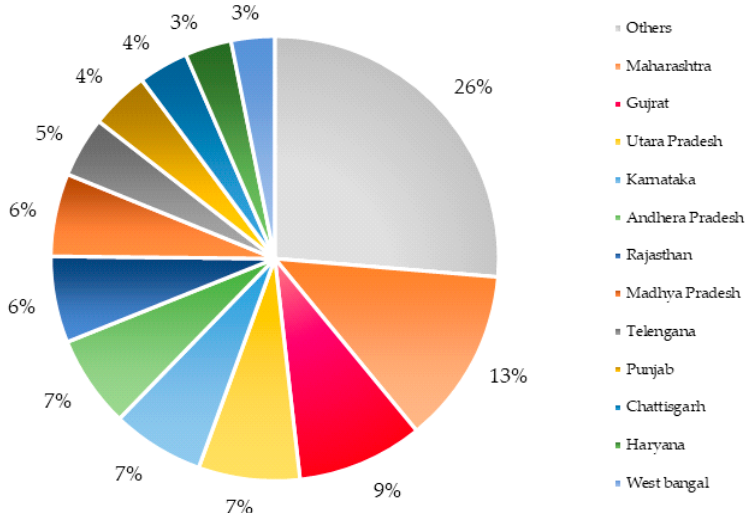
Figure 5. Generation Share of Electricity state-wise [29].